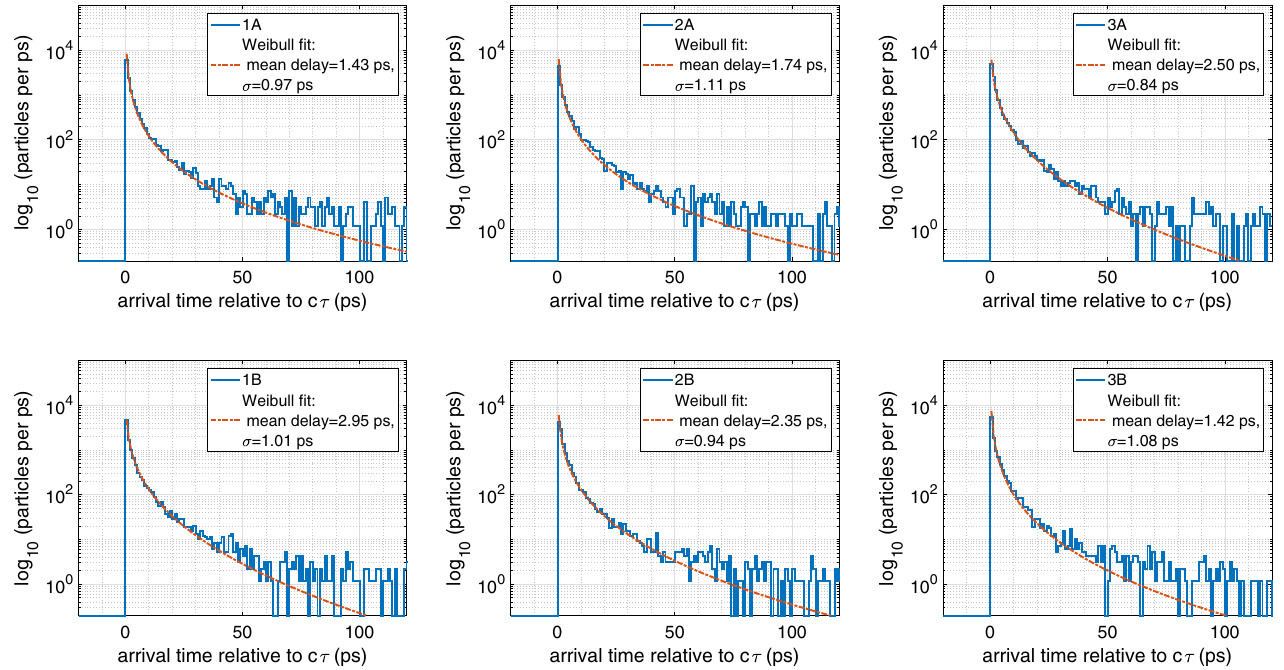
FIG. 23. GEANT 4 -simulated time delay distributions of 100 GeV pion-initiated shower particles, through 1.7 nuclear interaction lengths of material, relative to the light travel time from the injection point, along with fits of a Weibull probability density. The geometry of the figure panes is similar to the previous figure.